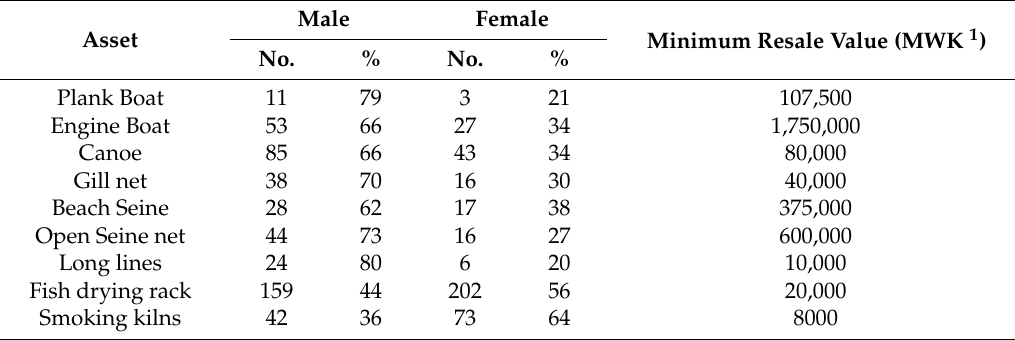
Table 5. Asset ownership by fisher folk in Mangochi and Salima